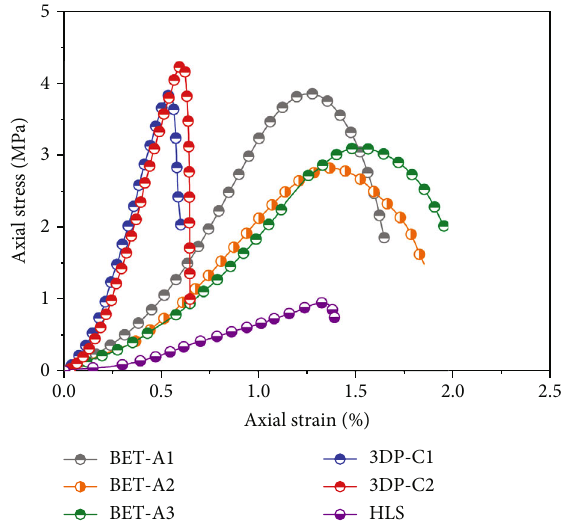
Figure 6: Stress-strain curves of 3DP sandstones and sandstone